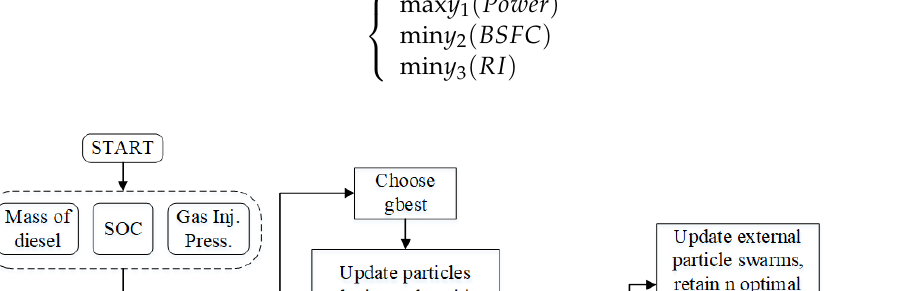
Table 7. Parameters of MOPSO.